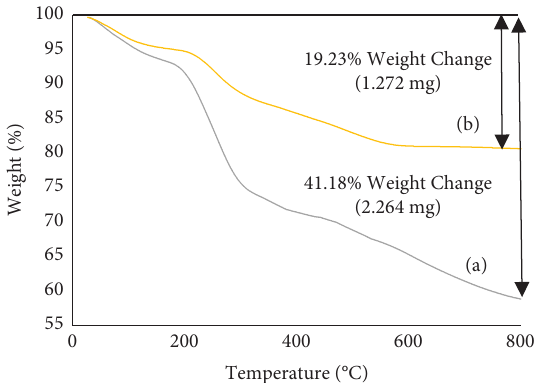
Figure 7: Termogravimetric analysis of alginate biopolymers (a) and alginate-zirconia bionanocomposites